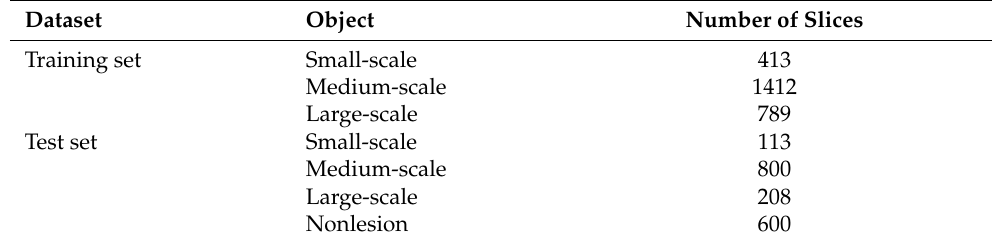
Table 1. Composition of the training set and test set.